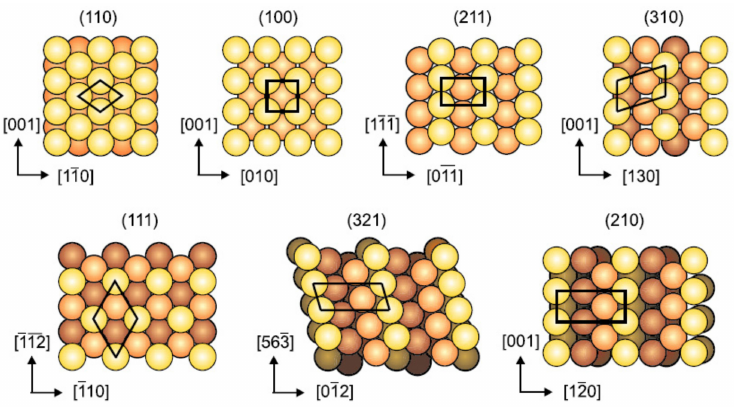
Figure 3. Top view of most densely packed surfaces of bcc structure, reproduced from [53], with permission from Elsevier,